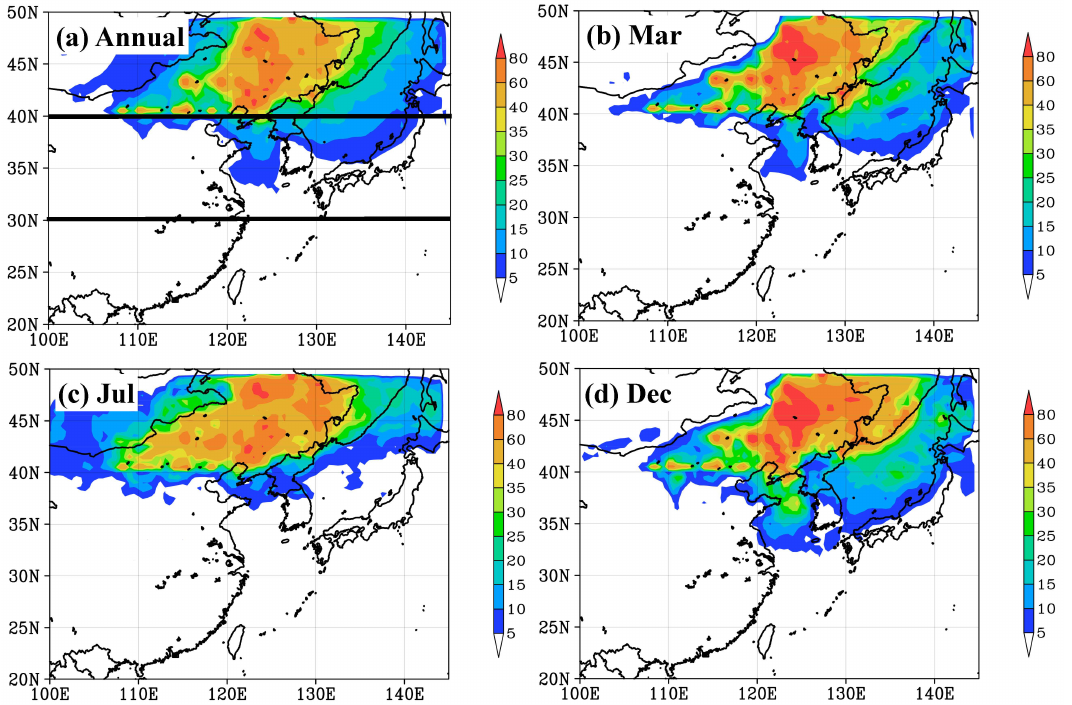
Fig. 5. Spatial distributions of (a) annual mean contributions of Source Region I to total sulfur deposition and monthly mean values for (b) March, (c) July, and (d) December (%). The solid lines in (a) indicate 40 ◦ N and 30 ◦ N, the borders between Regions I and II and between Regions II and III,